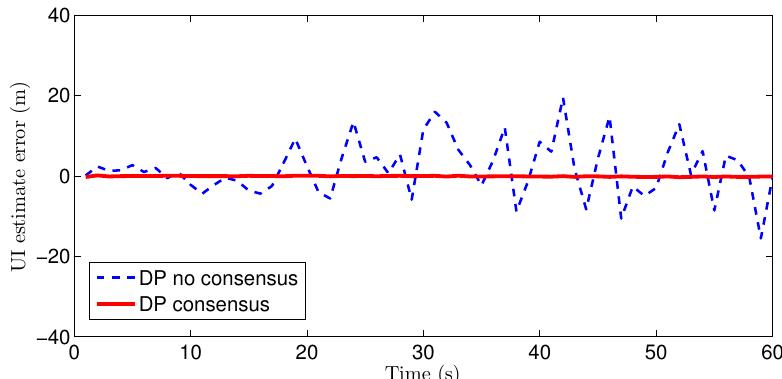
Figure 17. UI estimation errors of the DP consensus and DP no consensus methods for sensor 4 in the multi-sensor system of 60 sensors. Table 6. Comparison of mean estimation error values of the network of 60 sensors.